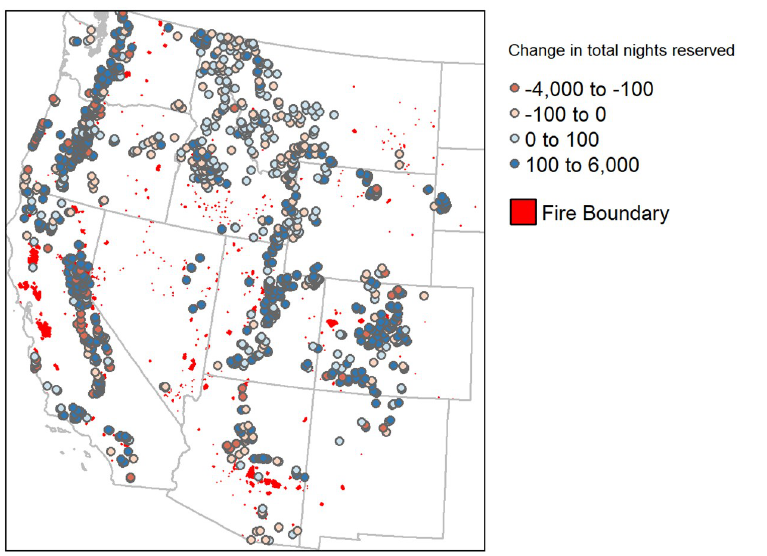
Fig 7. Wildfire perimeters in the western US in